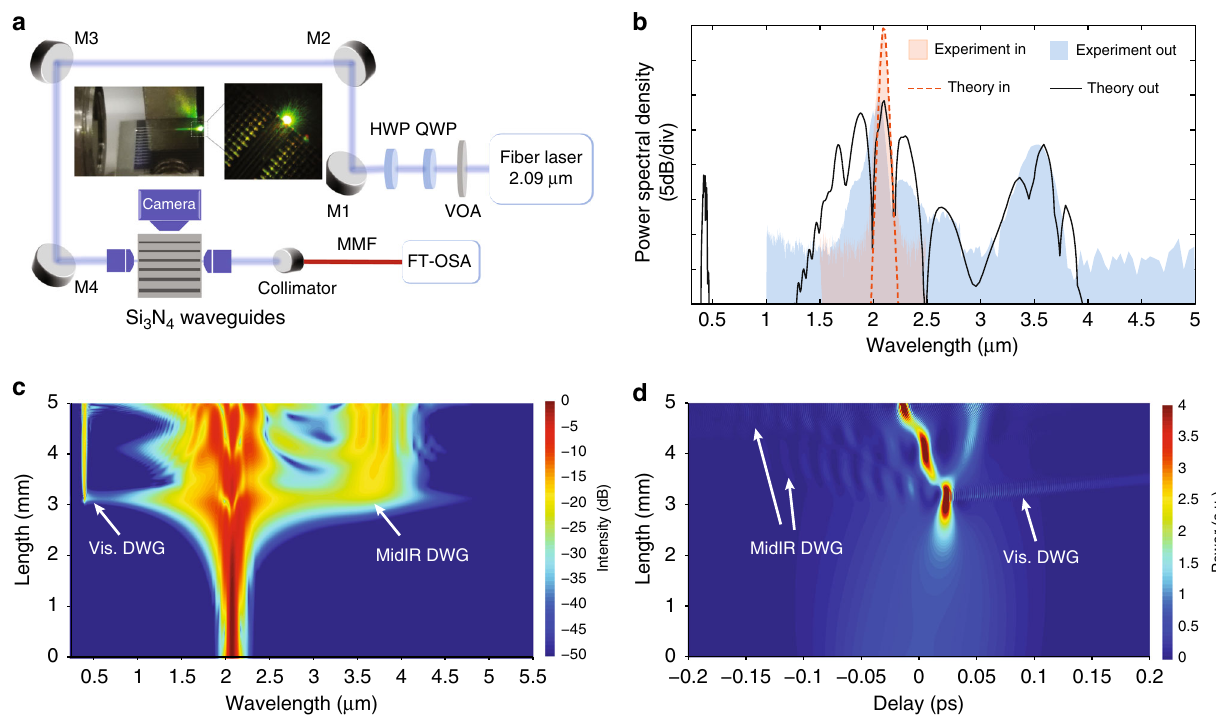
Fig. 2 Experimental set-up and dispersive wave generation. a Experimental set-up. HWP half wave plate, QWP quarter wave plate, M mirror, MMF multimode fi ber. The left inset is a picture of the chip and input coupling lens, while the right one is an image of the output of the waveguide taken from the top camera. Both images are taken under the same pumping condition. b Experimental (shaded region) and theoretical simulated (solid and dotted lines) input and output spectra for 13.6 mW average power coupled in the 1100 nm width waveguide. Spectral ( c ) and temporal ( d ) pump pulse evolution (dB scale) over the waveguide length for an input pulse of 110 fs at 2090 nm, with frequency chirp C = − 1000 fs 2 /2 π